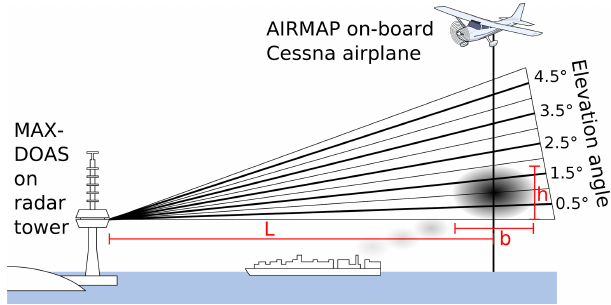
Figure 10. Sketch of the different measurement geometries of ground-based MAX-DOAS and airborne imaging DOAS instru- ments when measuring a ship plume. While the MAX-DOAS in- strument scans the plume vertically, the AirMAP instrument mea- sures in the nadir direction. Distances, heights, and sizes are not to